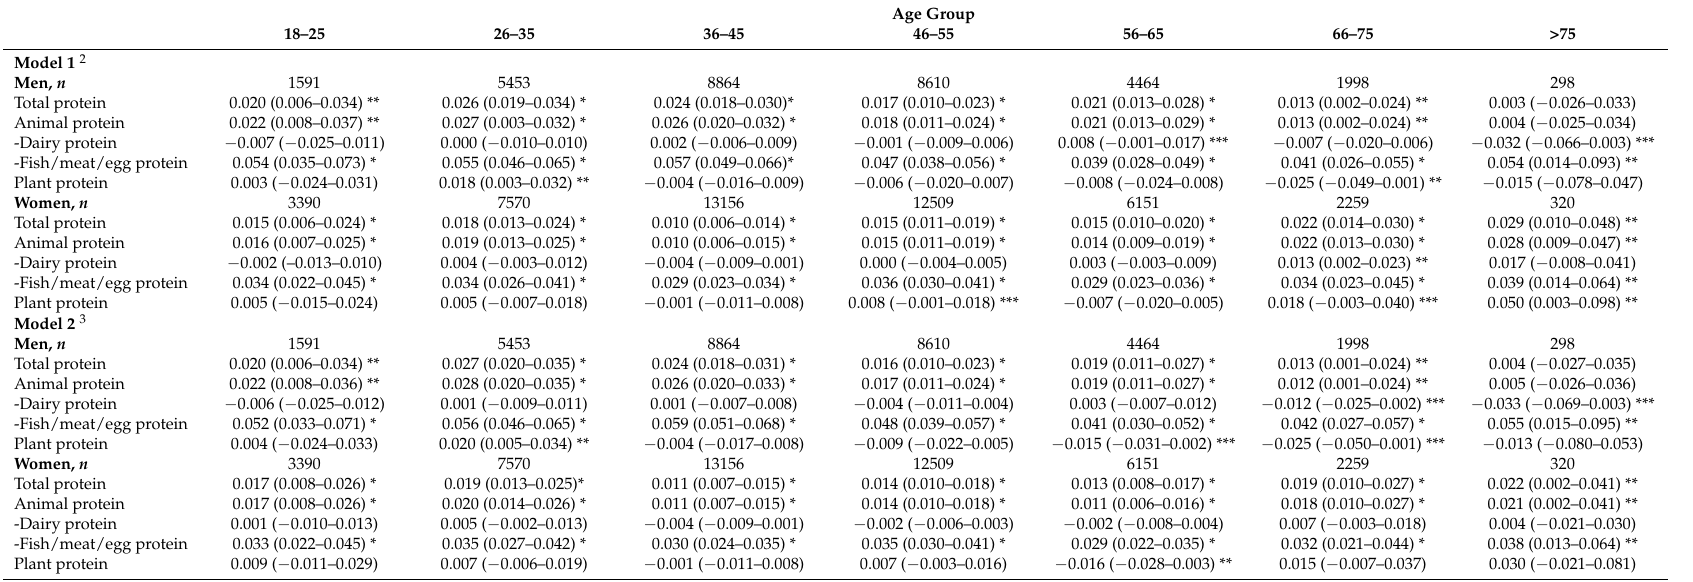
Table 4. Adjusted regression coefficients (and 95% CI) for creatinine excretion (mmoL/24 h) per unit of energy-adjusted protein intake among the different age groups 1